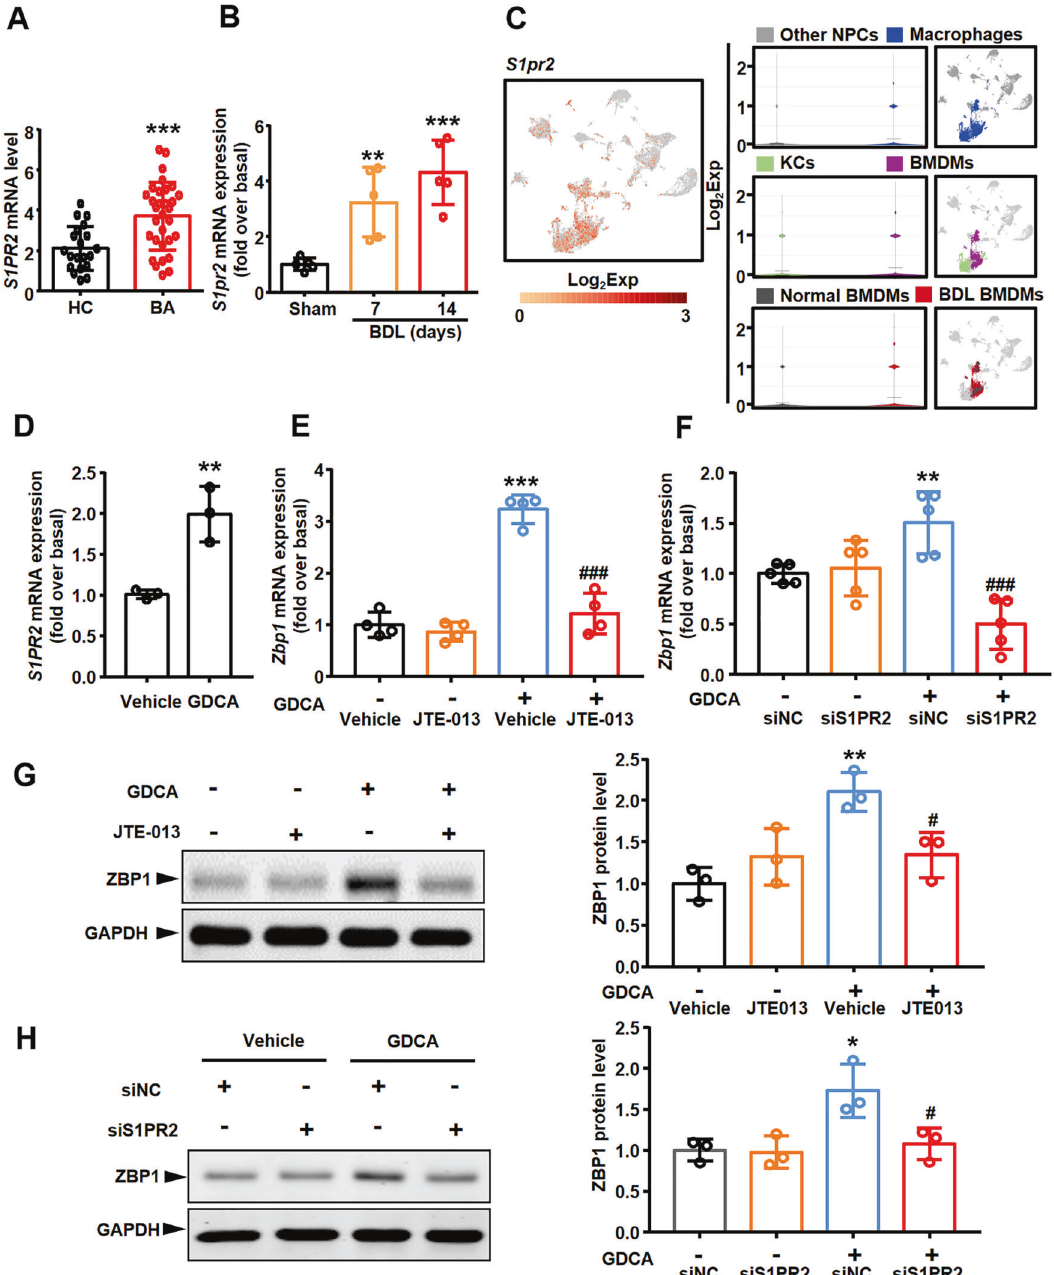
Fig. 7 GDCA increased ZBP1 expression in mouse BMDMs through S1PR2. A Hepatic S1PR2 mRNA level detected by RNA sequencing was compared between biliary atresia (BA, n = 31) and normal adjacent non-tumor livers (HC, n = 20). B mRNA level of S1pr2 in mouse livers was measured by qRT-PCR. C Violin plots showed S1pr2 expression of each cell clusters in scRNA-seq data. D S1pr2 mRNA level was measured by qRT-PCR in mouse BMDMs treated with 100 μ mol/L sodium glycodeoxycholate (GDCA) for 6 h. E Mouse BMDMs were pretreated with S1PR2 antagonist JTE-013 (10 μ mol/L) for 1 h, followed by 100 μ mol/L GDCA for 6 h, and Zbp1 mRNA level was measured by qRT-PCR. F Effect of S1pr2 siRNA on Zbp1 mRNA expression in response to 100 μ mol/L GDCA for 6 h. G ZBP1 protein level was measured in mouse BMDMs pretreated with JTE-013, followed by GDCA. H Effect of S1pr2 siRNA on ZBP1 protein expression in response to 100 μ mol/L GDCA for 6 h. All results were con fi rmed by at least three independent experiments. Data are presented as the mean ± SEM. * p < 0.05, ** p < 0.01, *** p < 0.001 (versus control). # p < 0.05, ### p < 0.001 (versus GDCA treated alone or GDCA with much higher in BA patients than in control subjects (Fig. 7A). induced the expression of ZBP1 in a time- and dose-dependent Similarly, qRT-PCR analysis also showed that mRNA level of S1pr2 manner (Fig. 6C – F). in liver was increased in BDL mice than in Sham mice (especially Bile acids activate multiple G-protein-coupled receptors, espe- on the 14th day after BDL) (Fig. 7B). Secondly, we explored the cially S1PR2 [30]. Herein, we further explored whether S1PR2 expression pattern of S1pr2 in different cell clusters through mediated the GDCA-induced upregulation of ZBP1 expression. scRNA-seq analysis. The results showed that S1pr2 was dominantly Firstly, RNA sequencing result showed that S1PR2 mRNA level was